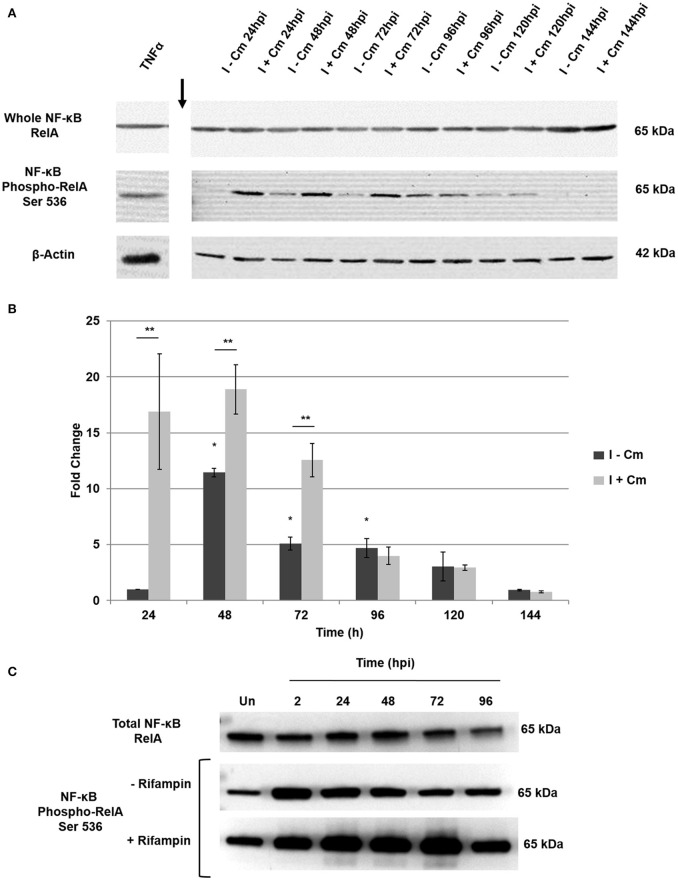
Temporal analysis of NF-κB activation in C. burnetii-infected THP-1 cells. (A) Representative immunoblots showing NF-κB activation and controls over a time course of C burnetii infection. Top panel—RelA probed with a monoclonal antibody. Middle panel—phosphorylated RelA probed with a monoclonal antibody against S536. Bottom panel—β-actin loading control. Time (hpi) at which untreated (I−Cm) and Cm-treated (I+Cm) C. burnetii-infected THP-1 cells were harvested is indicated above lanes. Arrow indicates lane break. (B) Fold change of phosphorylated RelA vs. time in the presence and absence of Cm. Results of densitometric analysis are presented as the mean of three experiments. Error bars show ±S.E.M. Statistical differences were calculated using a t-test for paired samples. *Signifies P < 0.05 of I-Cm samples compared to 24 hpi. **Signifies P < 0.05 between paired (I−Cm to I+Cm) samples at each time point. (C) A representative immunoblot showing phosphorylated RelA levels in PMA-differentiated THP-1 cells treated or mock-treated with Rifampin 2—96 hpi. Top panel—RelA control probed with a monoclonal antibody. Middle panel—phosphorylated RelA from infected cells mock-treated with Rifampin (−Rifampin). Bottom panel—phosphorylated RelA from infected cells treated with Rifampin (+Rifampin). Time (hpi) at which cells were harvested is indicated above each lane. Un = Uninfected cells.